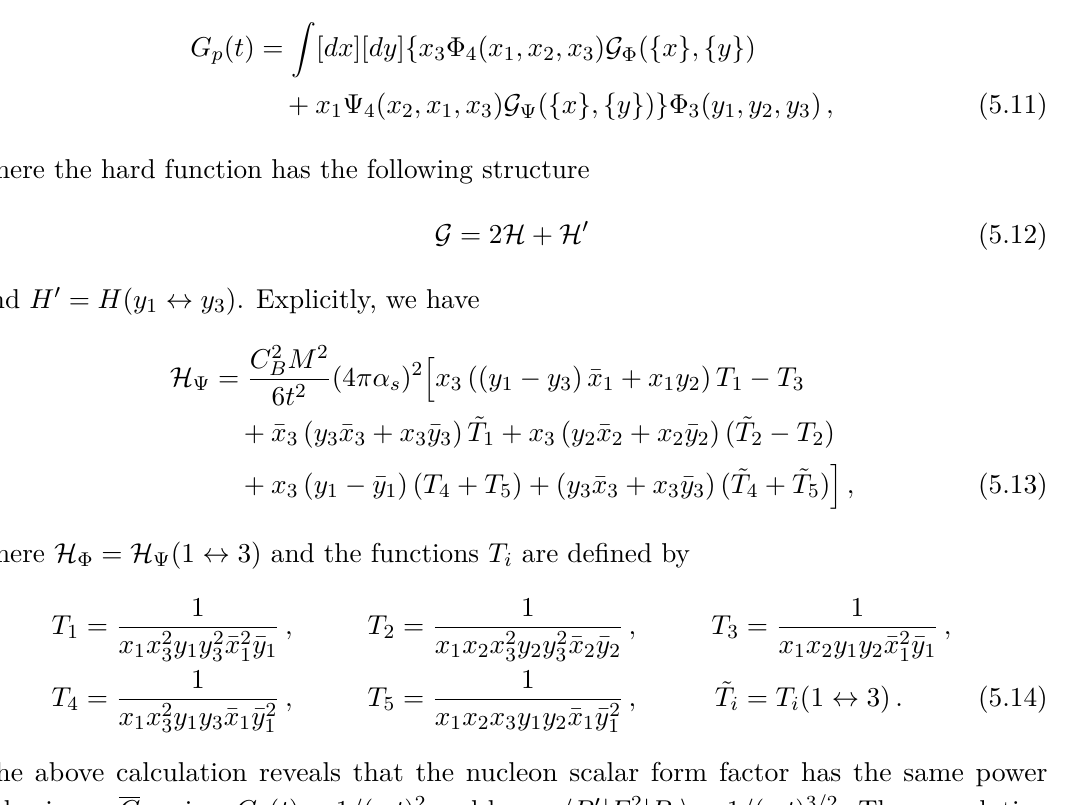
Figure 7. The scalar form factor for pion h P 0 | β ( g ) squared ( − t )